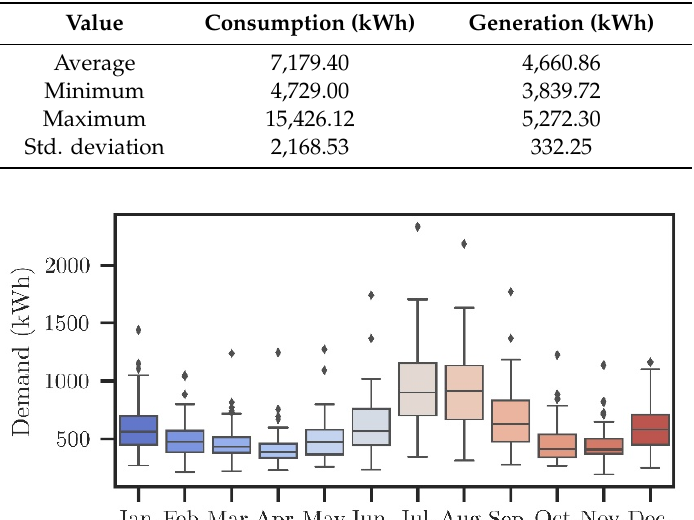
Table 1. Annual electricity generation and consumption of the analyzed households (n = 55).